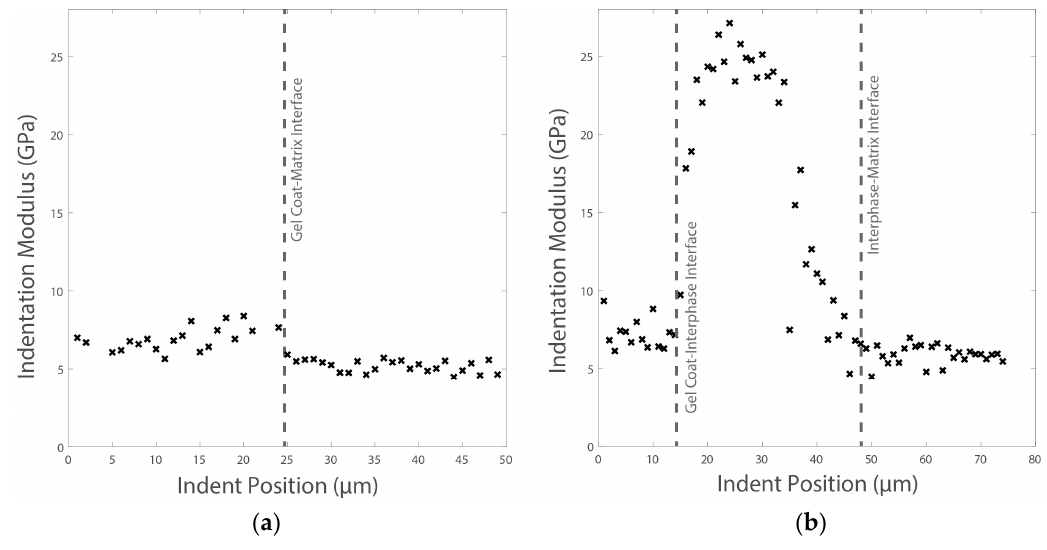
Figure 22. Two series of indents across the interface for the two samples of in-mould Gel Coating and the epoxy-based matrix of the GFRP laminate with different curing conditions: ( a ) Coat 1 (Cured) and ( b ) Coat 2 (Semi-cured).